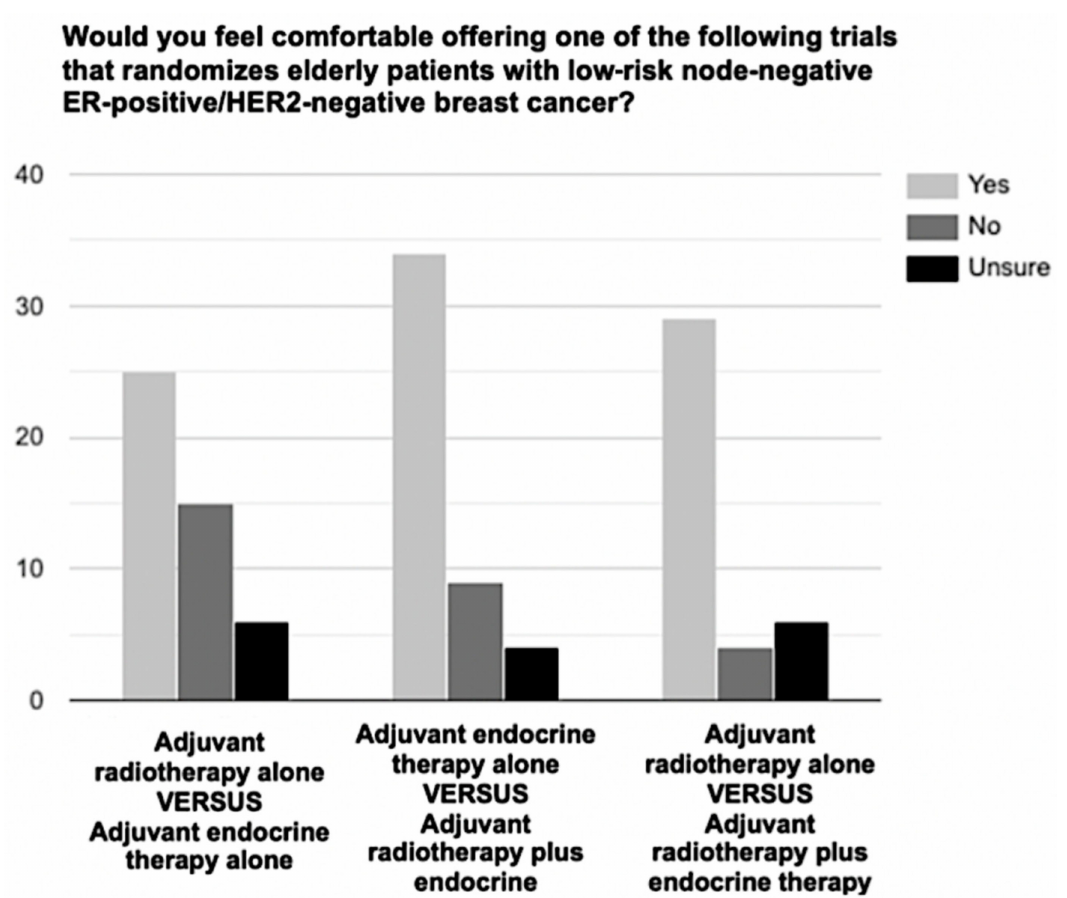
Figure 2. Oncologists comfort in offering future de-escalation trials